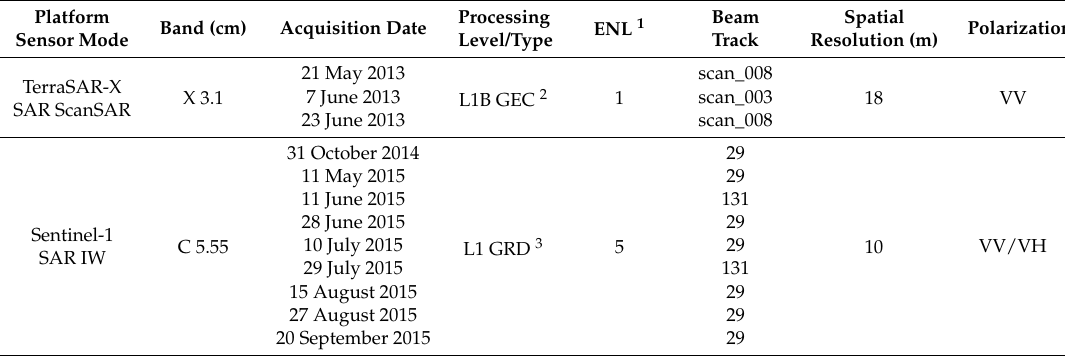
Table 1. Microwave data acquisitions over the Biebrza Wetland test